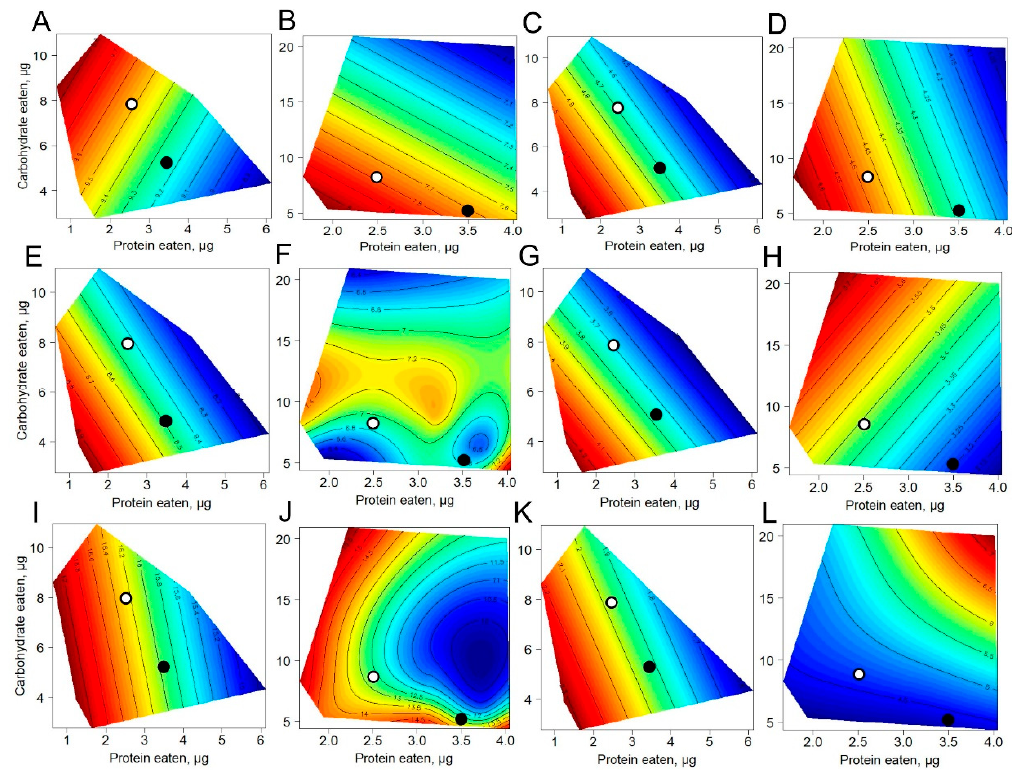
Figure 3. Response surfaces showing dependency of metabolite levels on macronutrients eaten. ( A ) body glucose on choice nutrition; ( B ) body glucose on no ‐ choice nutrition; ( C ) hemolymph glucose on choice nutrition; ( D ) hemolymph glucose on no ‐ choice nutrition; ( E ) body trehalose on choice nutrition; ( F ) body trehalose on no ‐ choice nutrition; ( G ) hemolymph trehalose on choice nutrition; ( H ) hemolymph trehalose on no ‐ choice nutrition; ( I ) glycogen on choice nutrition; ( J ) glycogen on no ‐ choice nutrition; ( K ) triglycerides on choice nutrition; ( L ) triglycerides on no ‐ choice nutrition. Open dots represent the values at P:C of 2.5:8 and filled dots for 3.5:5 P:C ratio. Red color on the response surfaces represents the highest values while dark blue shows the lowest ones, other colors represent intermediate values.